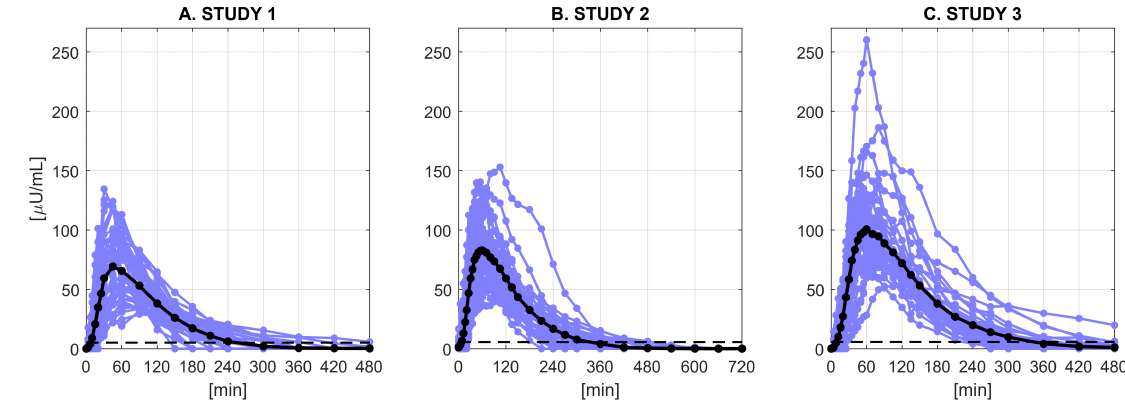
Figure 1. Plasma insulin concentration ( µ U/mL) in Study 1 ( A ), Study 2 ( B ), and Study 3 ( C ). Blue lines represent individual profiles, black lines the mean profile of each dataset, and dashed lines the BQL of each